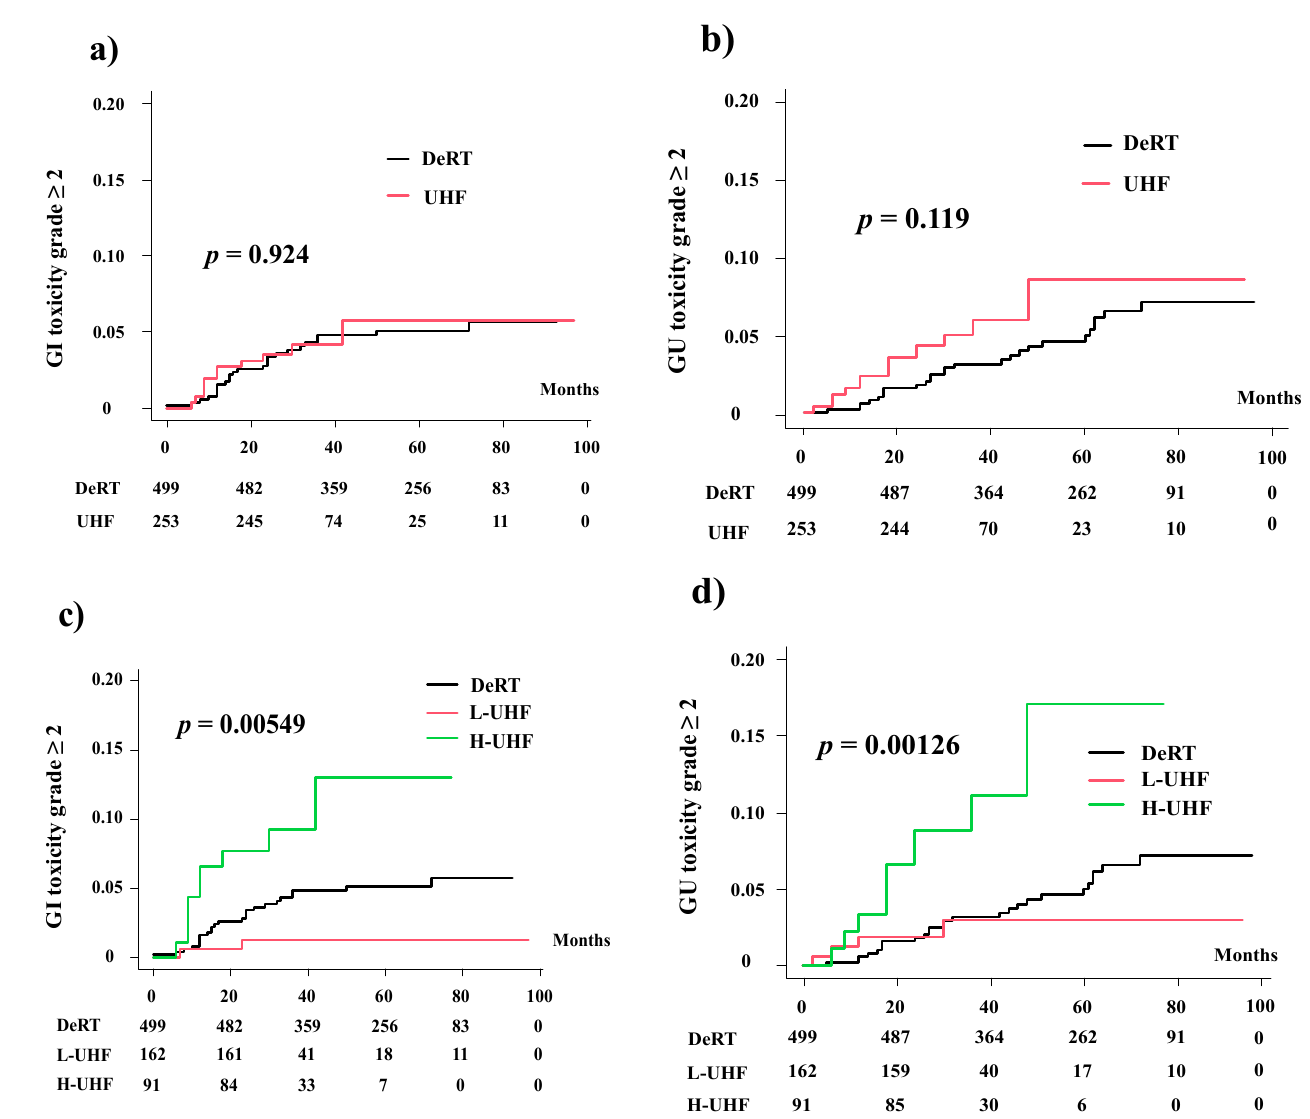
Figure 1. Comparison of accumulated incidence toxicity grade ≥ 2. ( a ) Accumulated incidence of grade ≥ 2 Gastrointestinal (GI) toxicity between DeRT and UHF. ( b ) Accumulated incidence of grade ≥ 2 Genitourinary (GU) toxicity between DeRT and UHF. ( c ) Accumulated incidence of grade ≥ 2 GI toxicity among three groups (DeRT vs. L-UHF vs. H-UHF). ( d ) Accumulated incidence of grade ≥ 2 GU toxicity among three groups (DeRT vs. L-UHF vs. H-UHF).